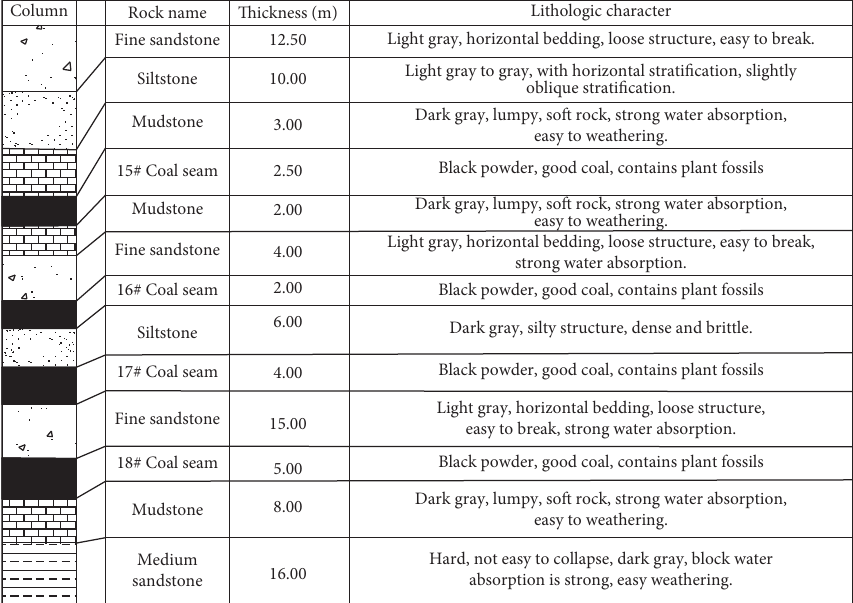
Figure 1: Stratigraphic section of selected layers.